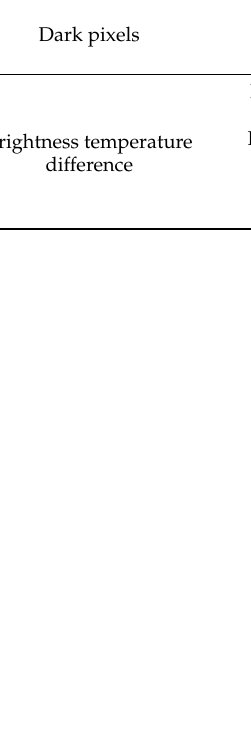
Table 9. Different target types and applicable target detection